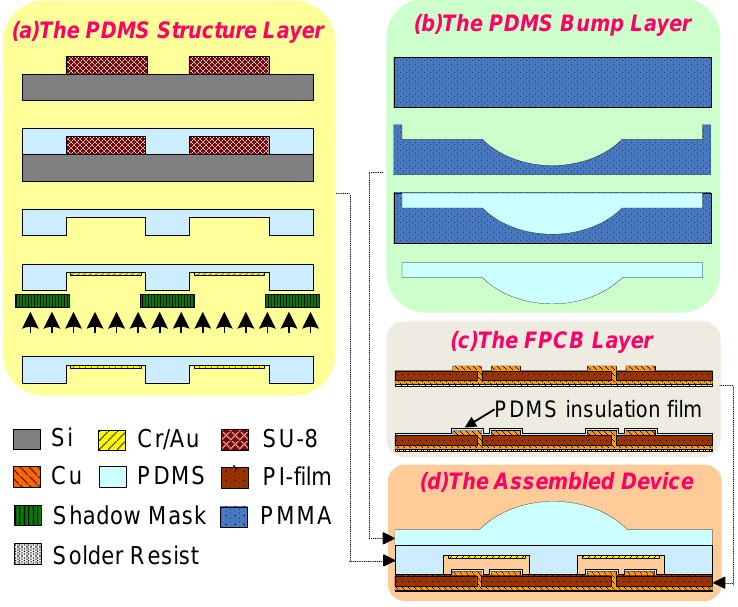
Figure 5. Fabrication process of the shear sensing